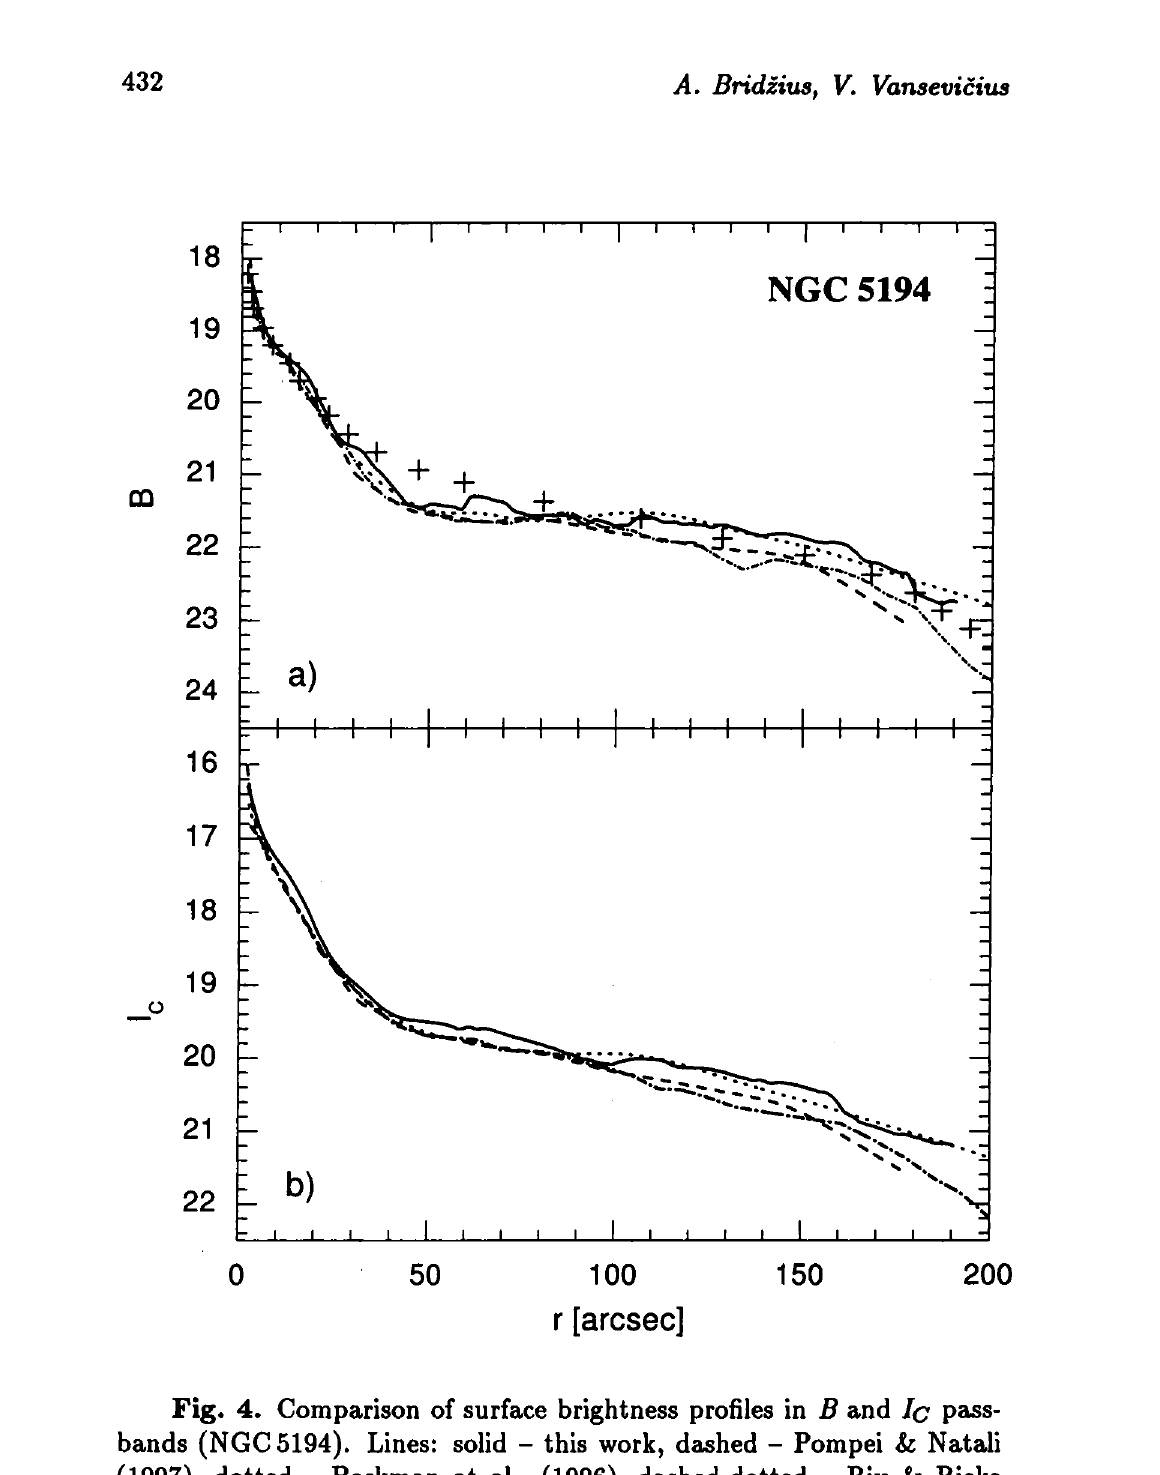
Fig. 4. Comparison of surface brightness profiles in B and Ic pass- bands (NGC5194). Lines: solid - this work, dashed - Pompei & Natali (1997), dotted - Beckman at al. (1996), dashed-dotted - Rix & Rieke (1993). Crosses are for Okamura at al.